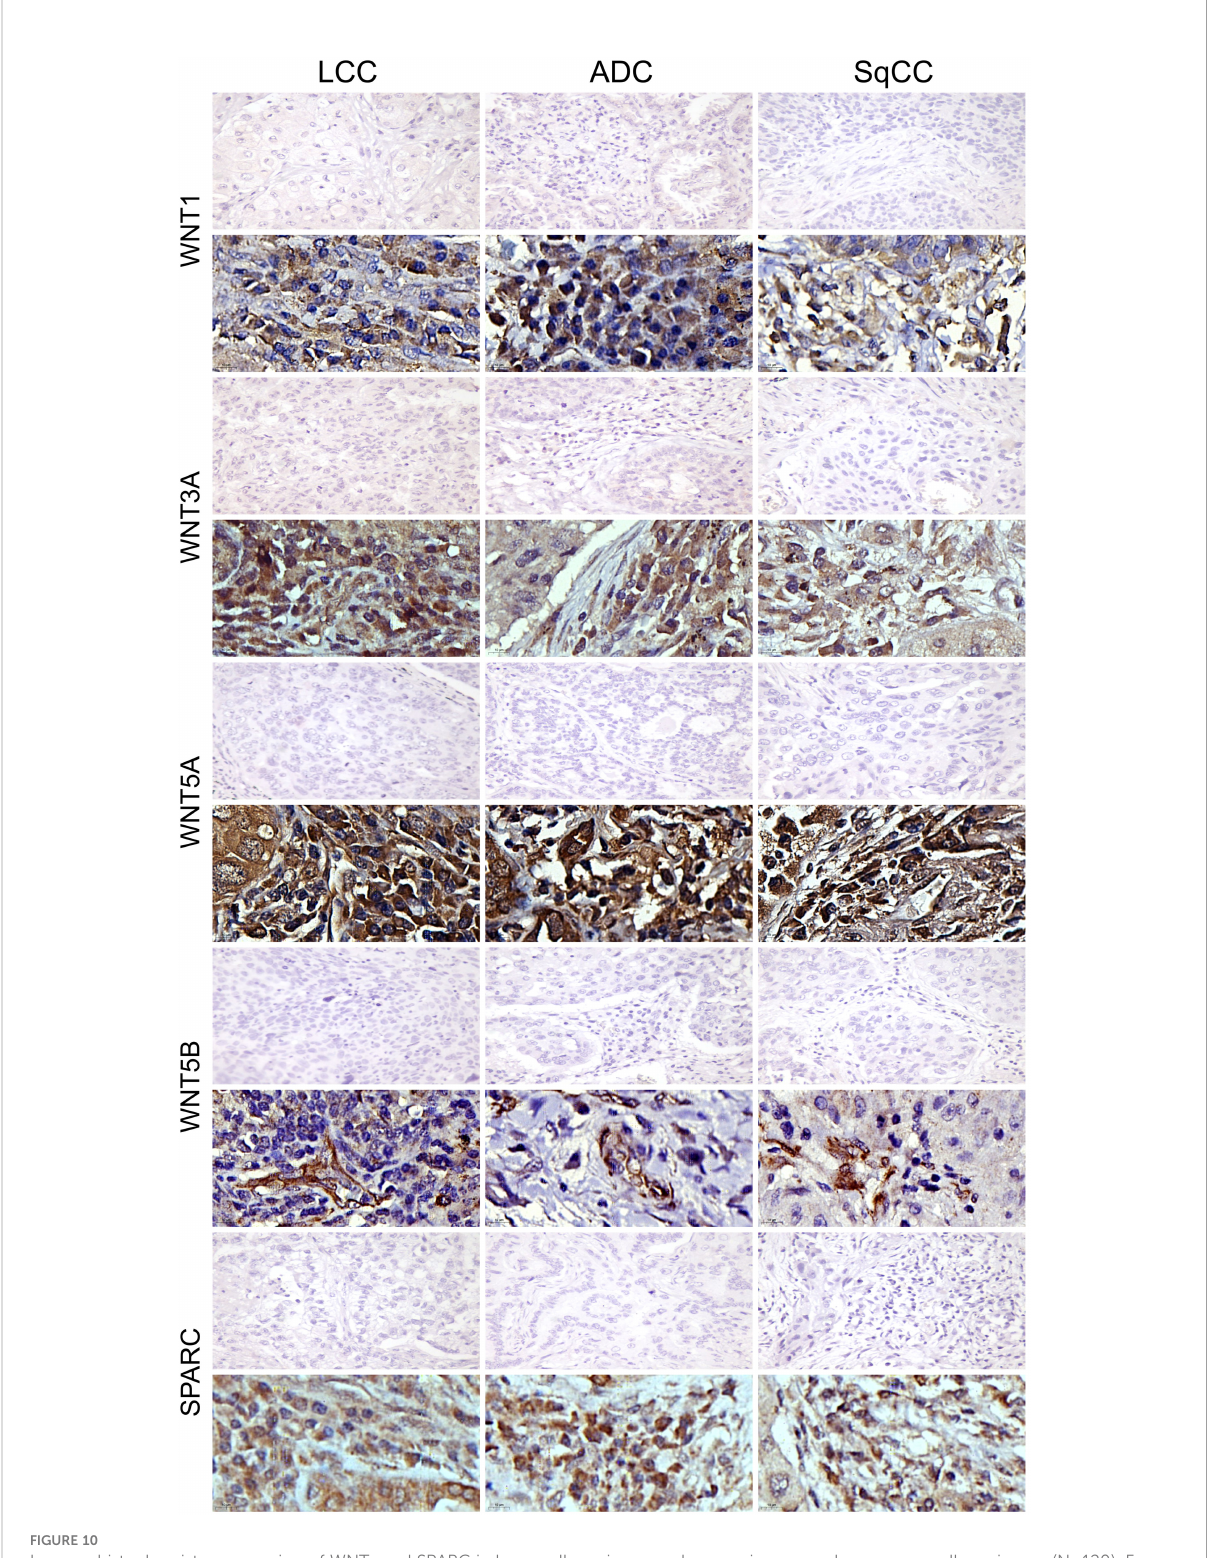
FIGURE 10 Immunohistochemistry expression of WNTs and SPARC in large cell carcinoma, adenocarcinoma, and squamous cell carcinoma (N=120). For both markers, the fi rst line illustrates the negative control. Original magni fi cation: 40X and 100X. LCC, large cell carcinoma; ADC, lung adenocarcinoma; SqCC: lung squamous cell